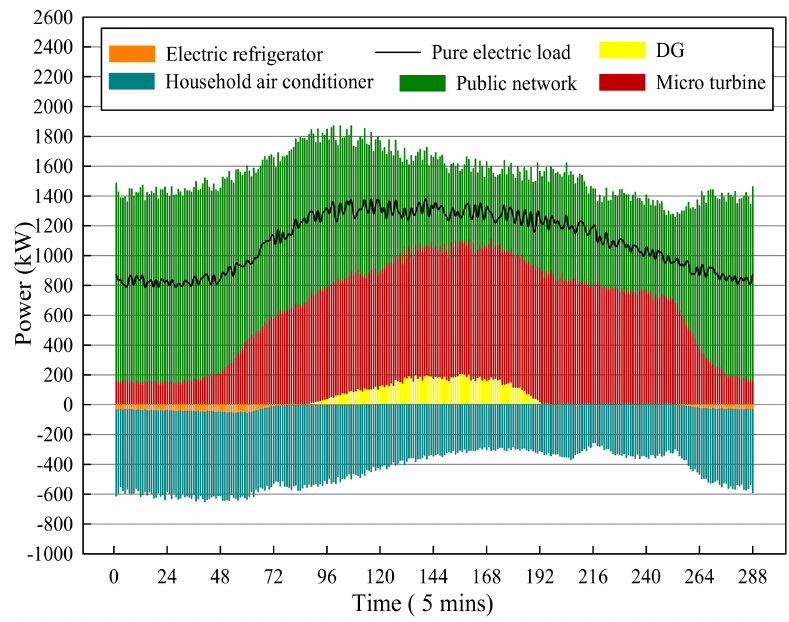
Figure 13. Real-time balance curve of pure electric